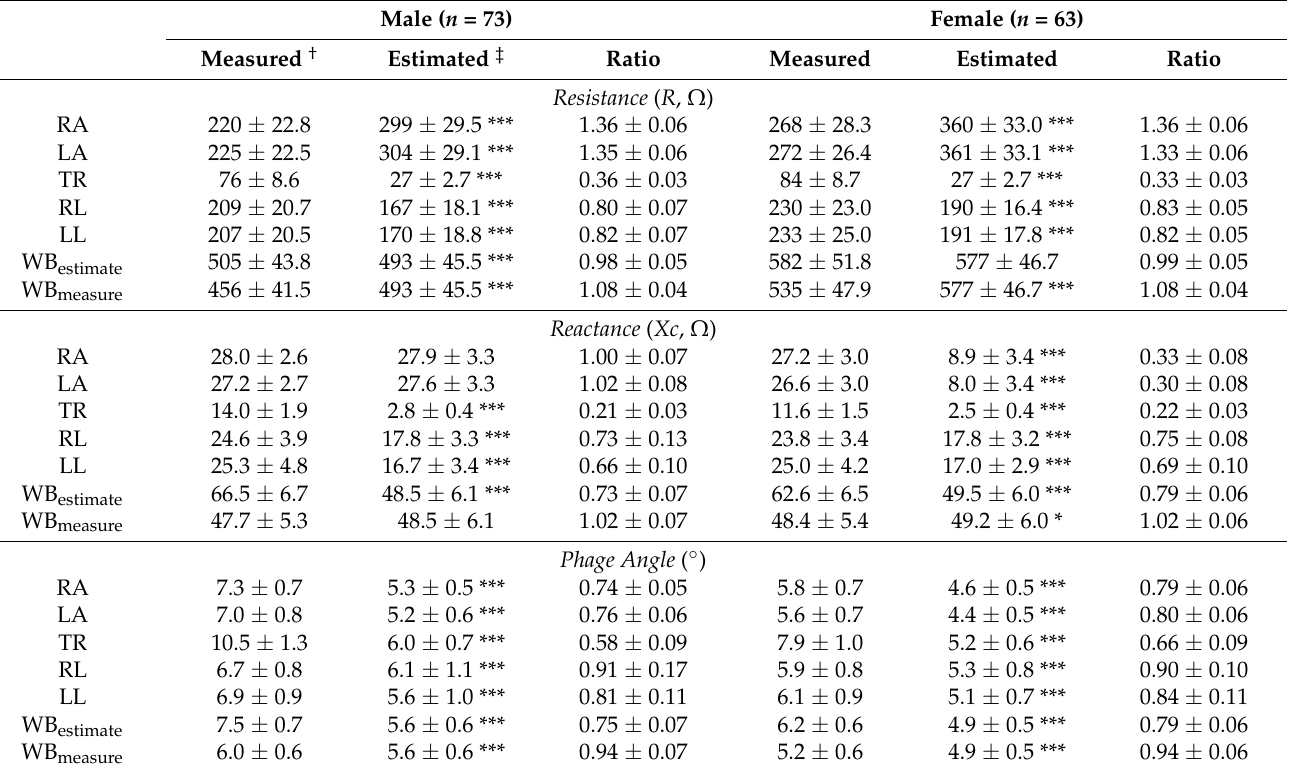
Values are mean ± SD; † = measured 4-electrode BIA parameters; ‡ = estimated 8-electrode BIA parameters; RA: right arm, LA: left arm, TR: trunk, RL: right leg, LL: left leg; WB estimate : Whole body as the sum of the segmental for right arm, trunk, and right leg. WB measure : Whole body as assessed by right-arm-to-right-foot 4-electrode BIA; * = Difference between the estimated and measured values at p < 0.05; *** = difference between the estimated and measured values at p <